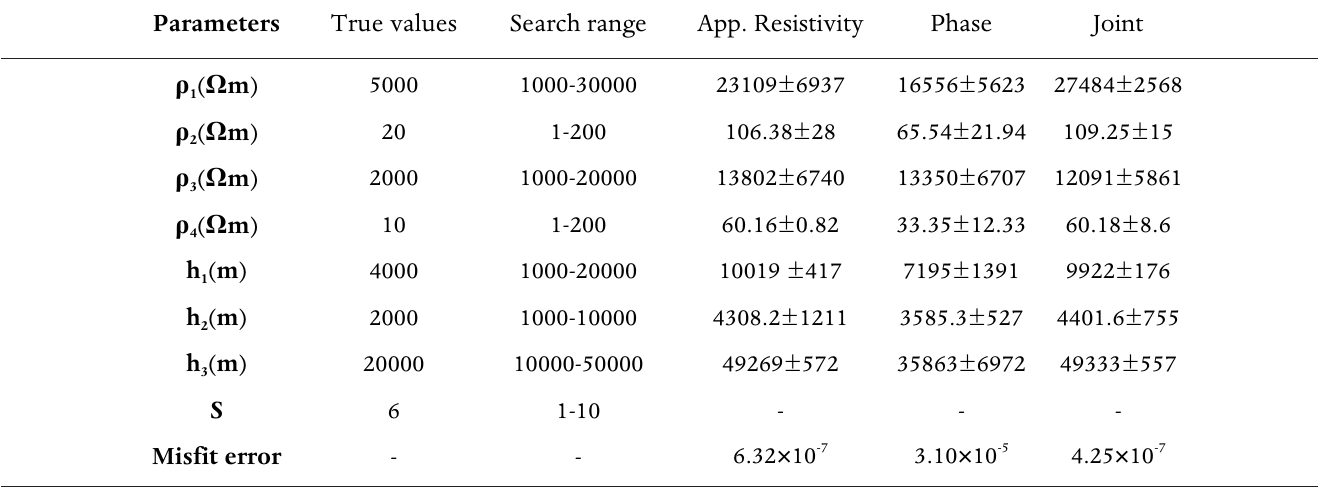
Table 5. Model 3: inversion results without optimization of static shift.